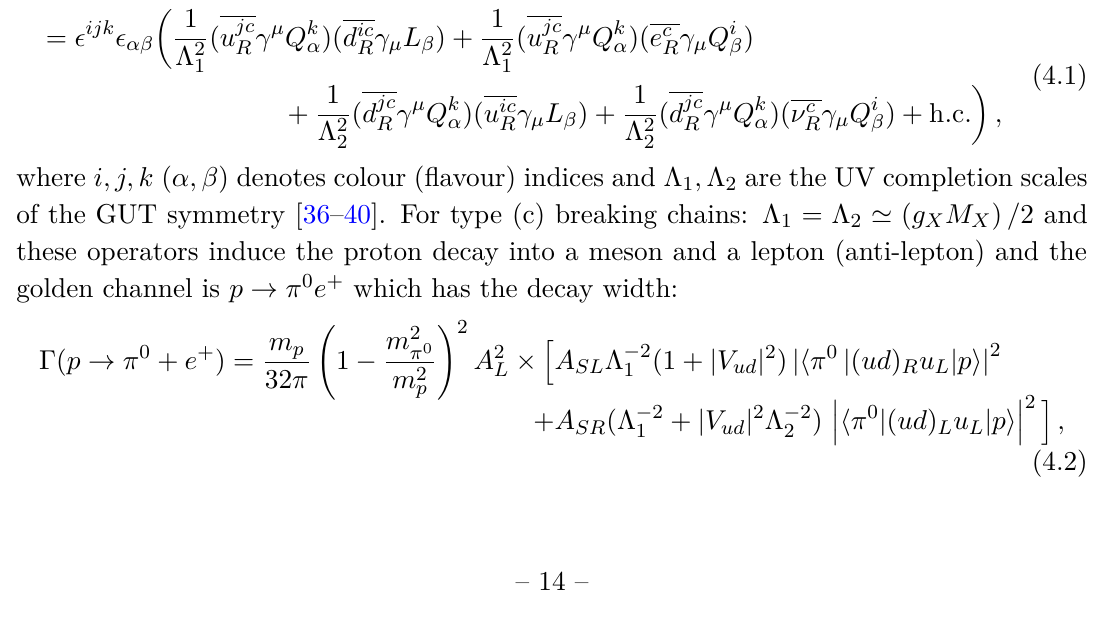
M 4 −−→ G M 3 −−→ G M 2 −−→ G M 1 −−→ G 4 3 2 1 SM